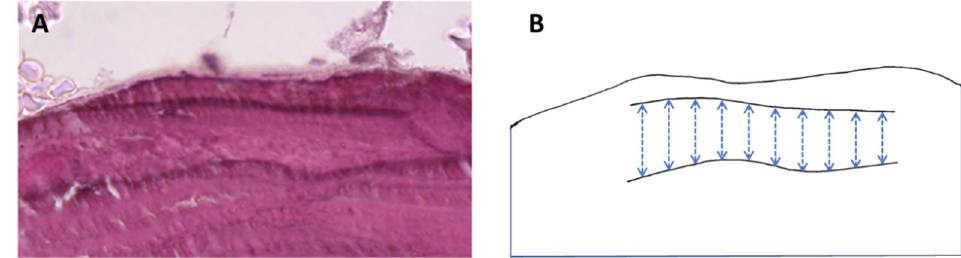
Figure A1. ( A ) Representative histological section indicating packet of trabecular bone and ( B ) representative measurements between cement lines.